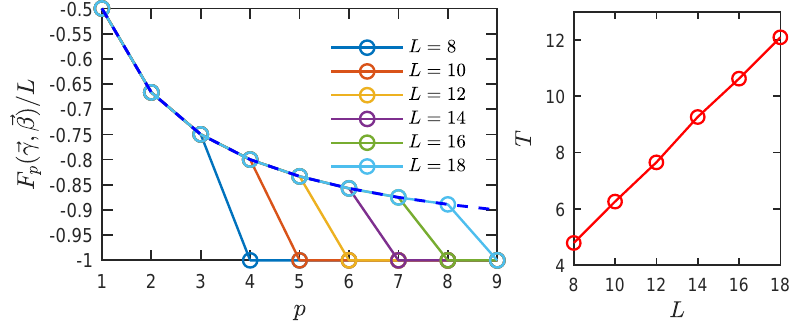
Figure 3: Preparation of GHZ state. (Left) Optimal cost function (6). One sees that ( γ , β ) / L = − 1 for p ≥ L / 2; in other words, the GHZ state is created with per- F p fect fidelity using VQCS . We have also plotted a conjectured analytic expres- p ≥ L / 2 sion − p / ( p + 1 ) (from [ 26 ] ) for the optimal cost function as the dashed blue line. (cid:148)(cid:80) p = L / 2 (cid:151) ( γ + β ) (Right) Total minimum time T = min ( γ required for the VQCS i i , β ) i to produce the GHZ state with perfect fidelity using VQCS . The minimization is p = L / 2 performed over all the numerical solutions found. One sees a linear trend T ∼ L